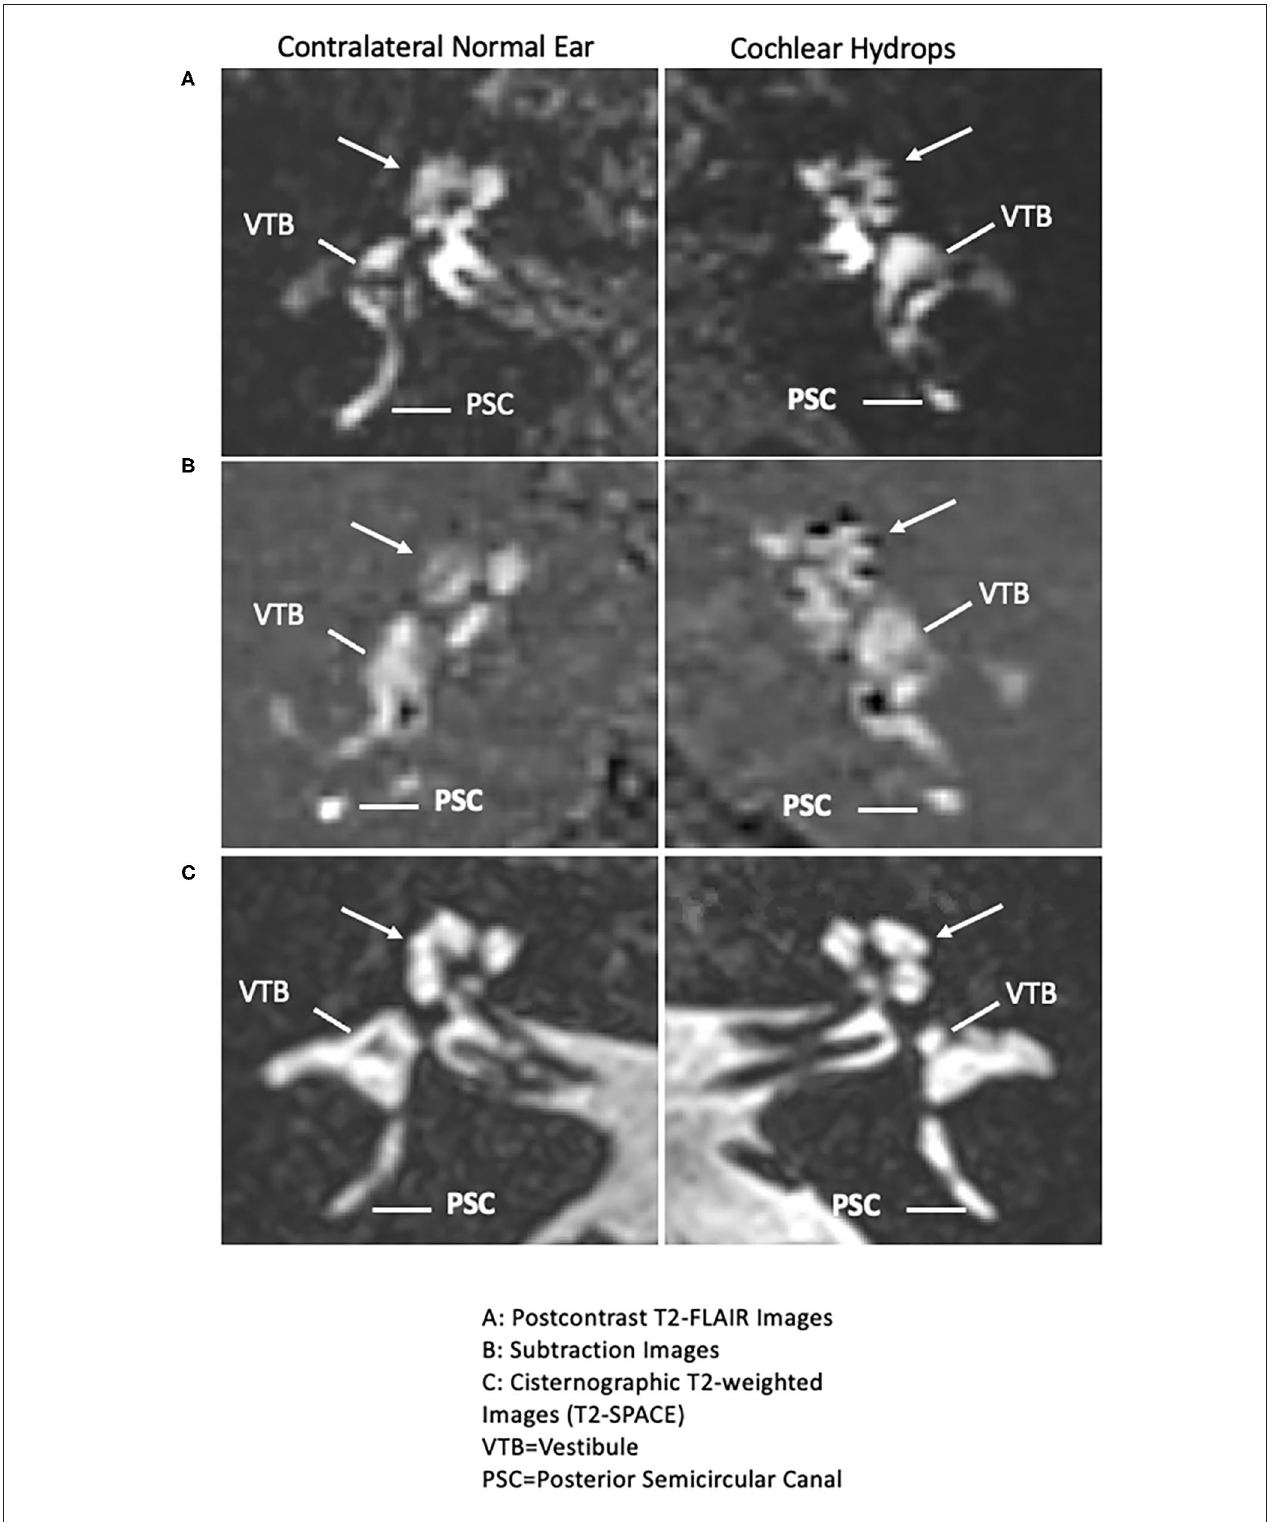
FIGURE 1 | Isolated cochlear endolymphatic hydrops on 3T MRI: Right column: Cochlear hydrops and Left column: contralateral normal ear. (A) (Top right panel: Cochlear hydrops), delayed postcontrast T2-FLAIR images through the cochlea demonstrate a prominent scala media signal void consistent with a dilated